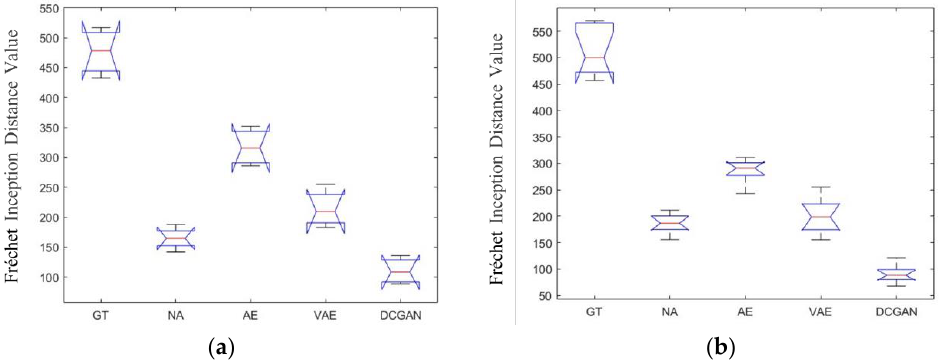
Figure 12. The ANOVA stats of the FID on data set 1 ( a ) and data set 2b ( b ).